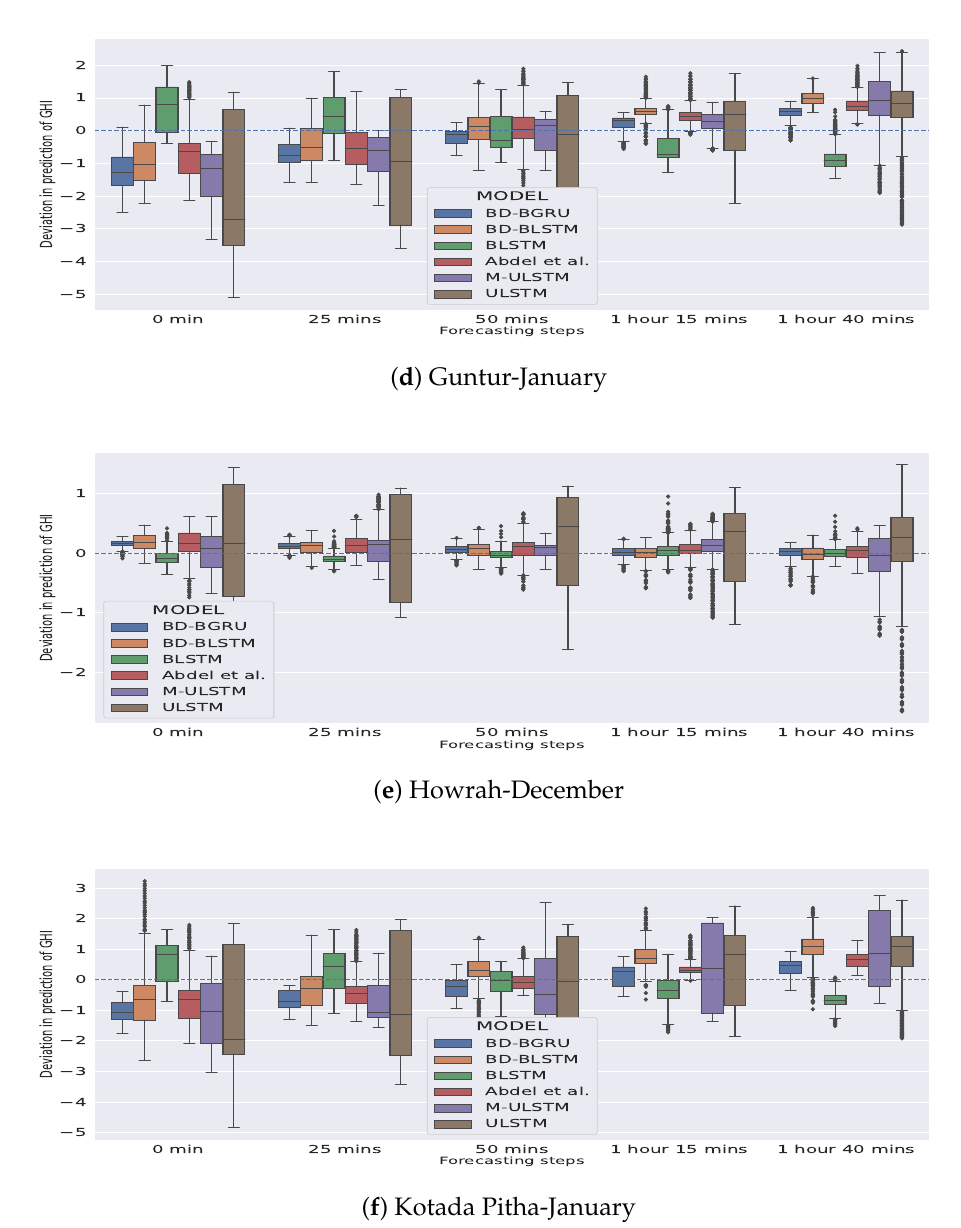
Figure 5. Variability in deviation of GHI (W/m 2 ) in the winter season. Similarly, in the rainy season, BD-BGRU achieved the lowest variability in its deviation of GHI compared to other models. ULSTM has performed the worst for both winter and rainy seasons. Furthermore, compared to other models for all forecasting horizons, BD-BGRU achieved much lower divergence in its predictions compared to the actual.